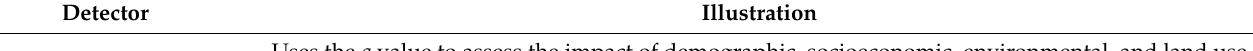
Table 2. Conceptual framework of the geographical detector method.